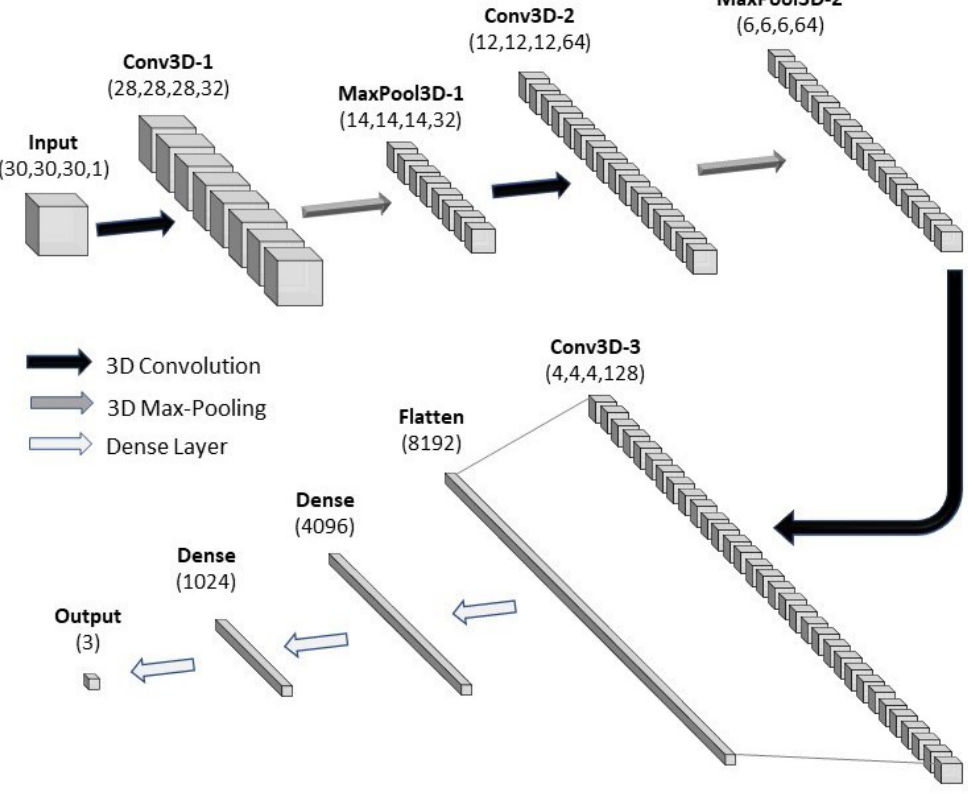
Figure 1. Diagram of the model architecture used in our investigation. A cosine loss function was used for the initial direction model and MSE loss for the head